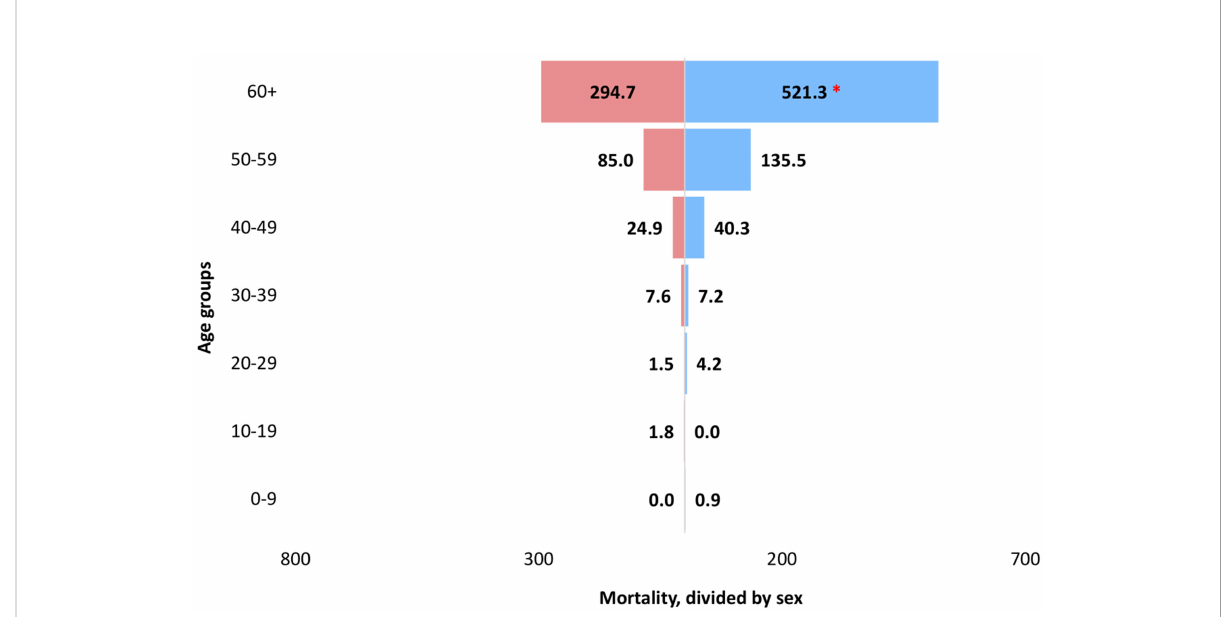
FIGURE 5 Incidence of SARS-CoV-2 death cases in the period January 2020 – December 2021 by age and sex. The statistically signi fi cant difference in the number of death cases between males and females in the 60+ age group (p=0.001) was marked with asterisk (*). Males designated with blue, while females with red color,